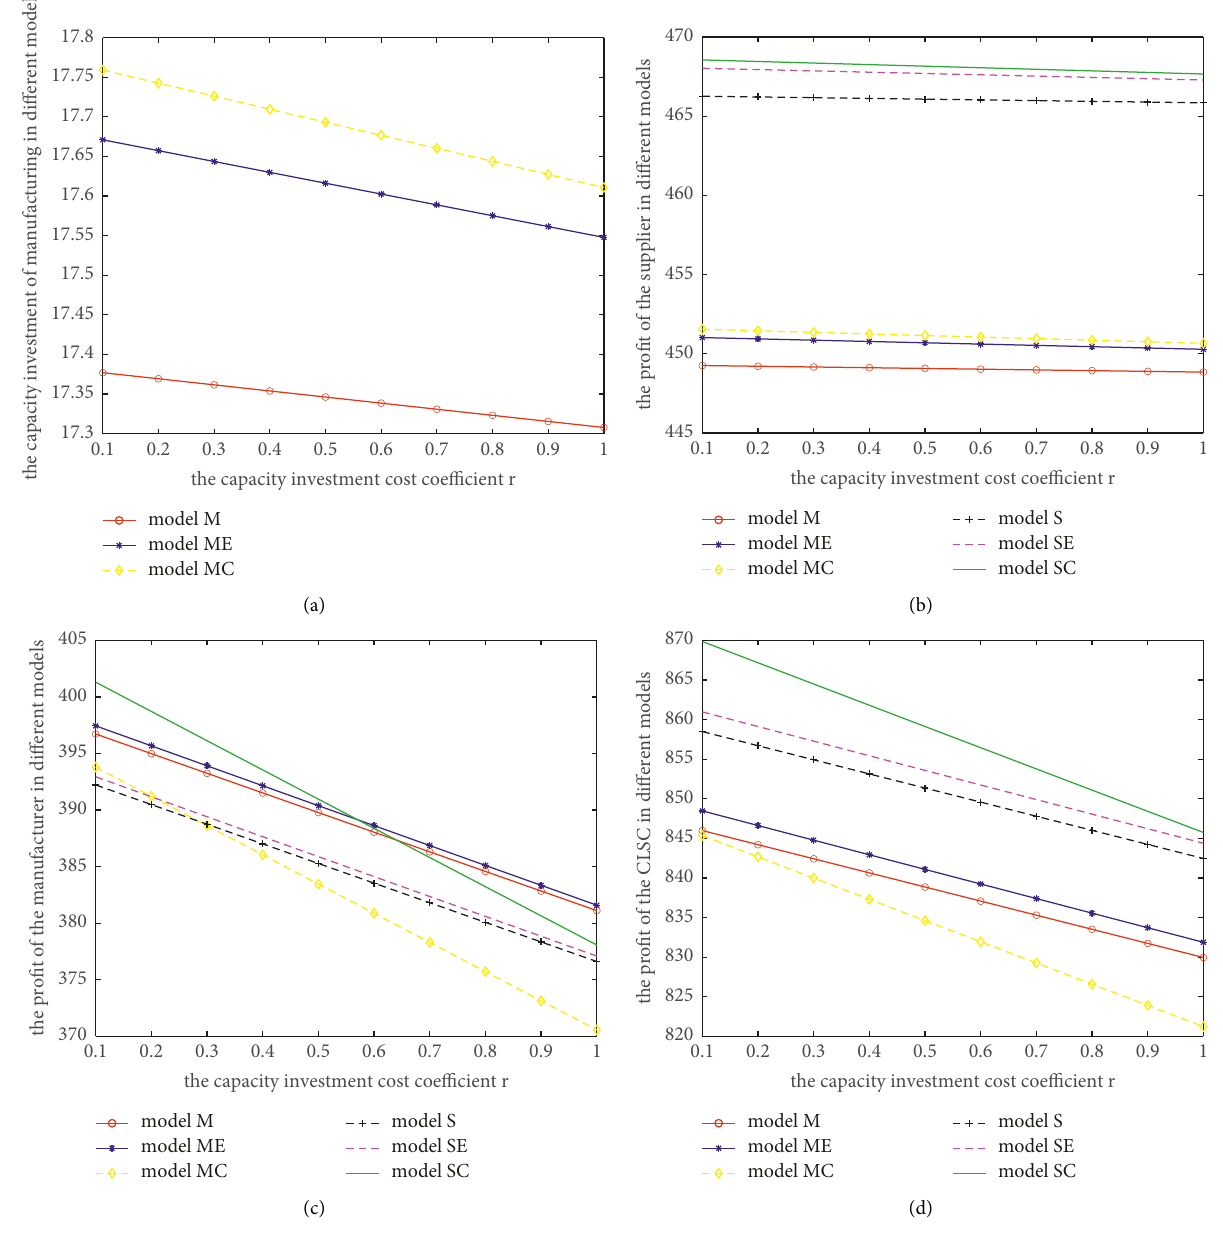
Figure 5: The capacity investment cost coefficient r . (a) The capacity investment of manufacturing in different models. (b) The profit of the supplier in different models. (c) The profit of the manufacturer in different models. (d) The profit of the CLSC in different